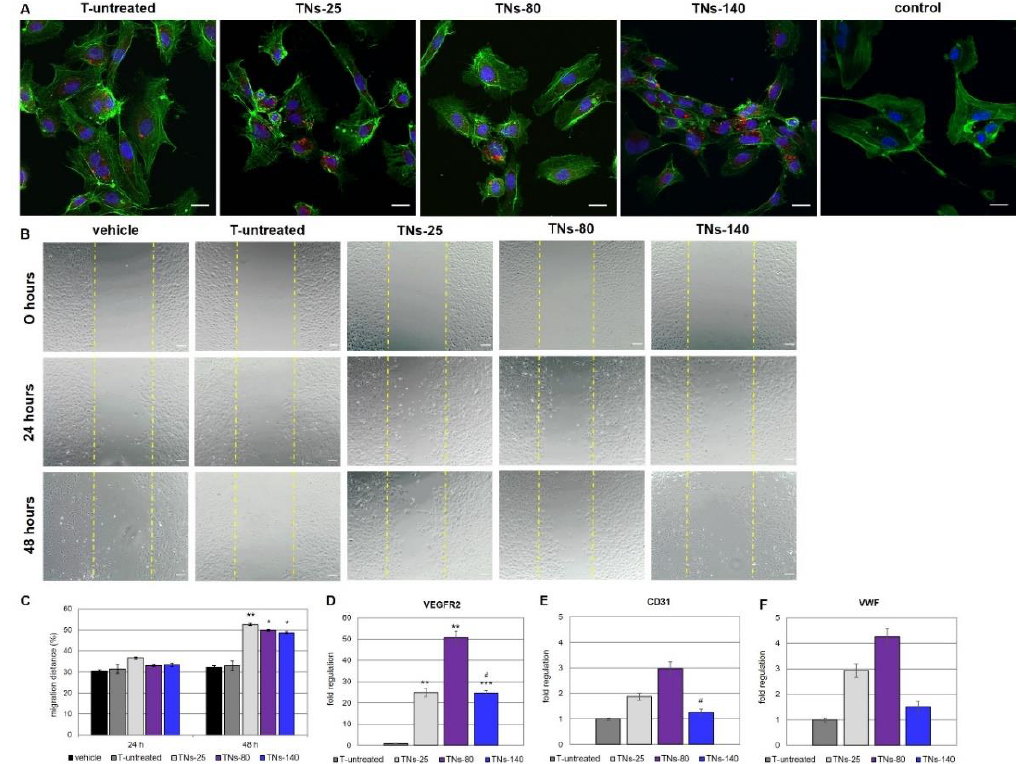
Figure 7. Effects of exo-hMSCs on HUVECs in vitro. ( A ) Internalization of exo-hMSCs by HUVECs. Representative confocal microscope images of HUVECs exposed to BODIPY™ TR ceramide-labeled exosomes ( red ) isolated from hMSCs seeded on T-untreated, TNs-25, TNs-80, and TNs-140 surfaces, or to BODIPY™ TR ceramide-labeled PBS (control). At 4 h post treatment with exosomes, HUVECs were stained with phalloidin ( green ), while nuclei were counterstained with DAPI ( blue ). Scale bar 20 µ m. ( B ) Wound healing migration assay of HUVECs treated with the different exo-hMSCs preparations. Representative images of HUVECs migration after treatment for 24 and 48 h with vehicle (PBS), or with exo-hMSCs recovered from T-untreated, TNs-25, TNs-80, and TNs-140 surfaces. Scale bar 100 µ m. ( C ) Migration distance calculated at 24 and 48 h post exosomes incubation. Data are expressed as the means ± SD. Note: * p < 0.05 and ** p < 0.01 mark significant changes in migration distance of HUVECs treated with hMSCs-derived exosomes compared to cells incubated with vehicle for the same culture time. Gene expression profiles of the endothelial cell-specific markers ( D ) VEGFR2, ( E ) CD31, and ( F ) VWF measured by real-time PCR in HUVECs treated for 48 h with the different exo-hMSCs preparations. Data are expressed as means ± SD of the target gene versus reference gene (TFRC) ratio and represented by 2 ∆∆ Ct . Note: ** p < 0.01, and *** p < 0.001 mark significant changes in gene expression level compared to HUVECs incubated with exo-hMSCs isolated from untreated surfaces for the same culture time; # p < 0.05 indicates significant changes in gene expression level versus HUVECs incubated with exo-hMSCs isolated from TNs-80.